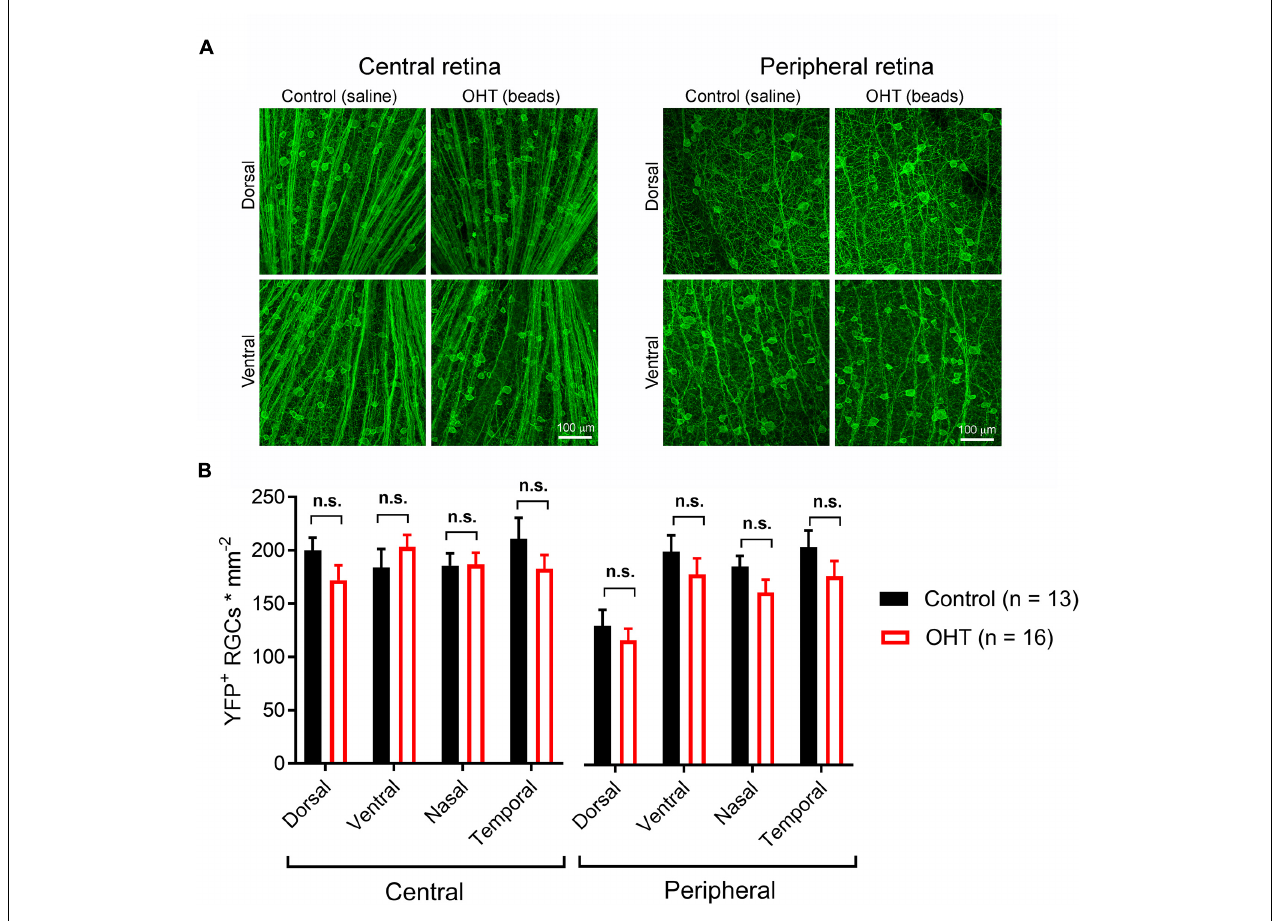
FIGURE 10 | Five weeks of OHT does not lead to a detectable loss of melanopsin-expressing RGCs. (A) In order to test for changes in the density of RGCs expressing the ChR2-YFP reporter, the somata, axons, and dendrites of ChR2-YFP expressing RGCs were stained using anti-GFP primary antibodies in retinal flat mounts. RGC somata were counted in central retina ( ∼ 500 microns from optic nerve head) and peripheral retina ( ∼ 1700 microns from optic nerve head) in dorsal, ventral, nasal, and temporal quadrants (determined by co-staining for S-opsin). (B) YFP + RGC somata density in four quadrants of central and peripheral retina. RGC density did not significantly differ between control and OHT groups (n.s., p >